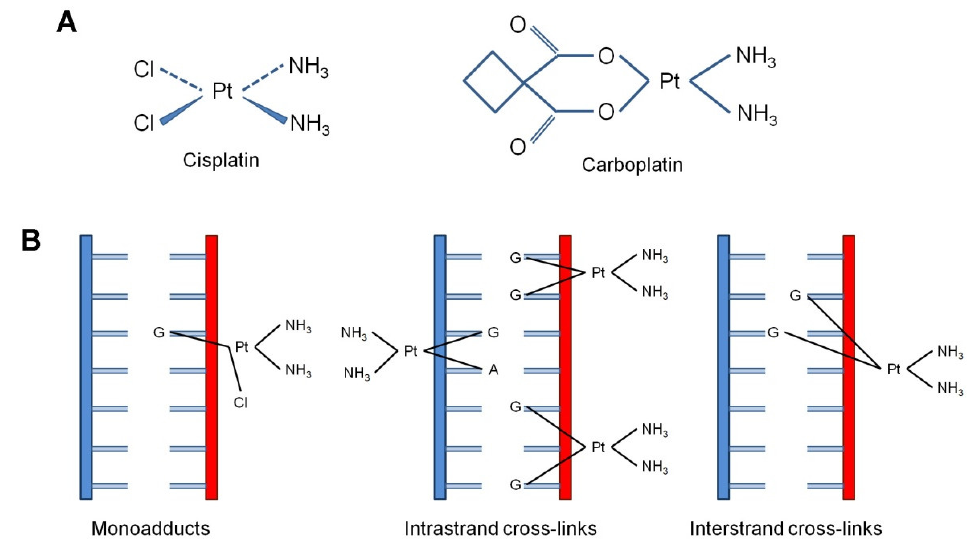
Figure 1. Cisplatin-induced DNA adducts. ( A ) Structure formulas of cisplatin and carboplatin. ( B ) The type of DNA adducts formed by cisplatin: single-nucleotide damage of guanine (monoadducts), intra-strand cross-links [Pt-d(GpG)], 1,2-intra-strand crosslinks, 65%; Pt-d(ApG), 1,2-intra-strand cross-links, 25%; Pt-d(GpNgG), 1,3-intra-strand cross-links, 5–10%] and inter-strand cross-links (1.5%).